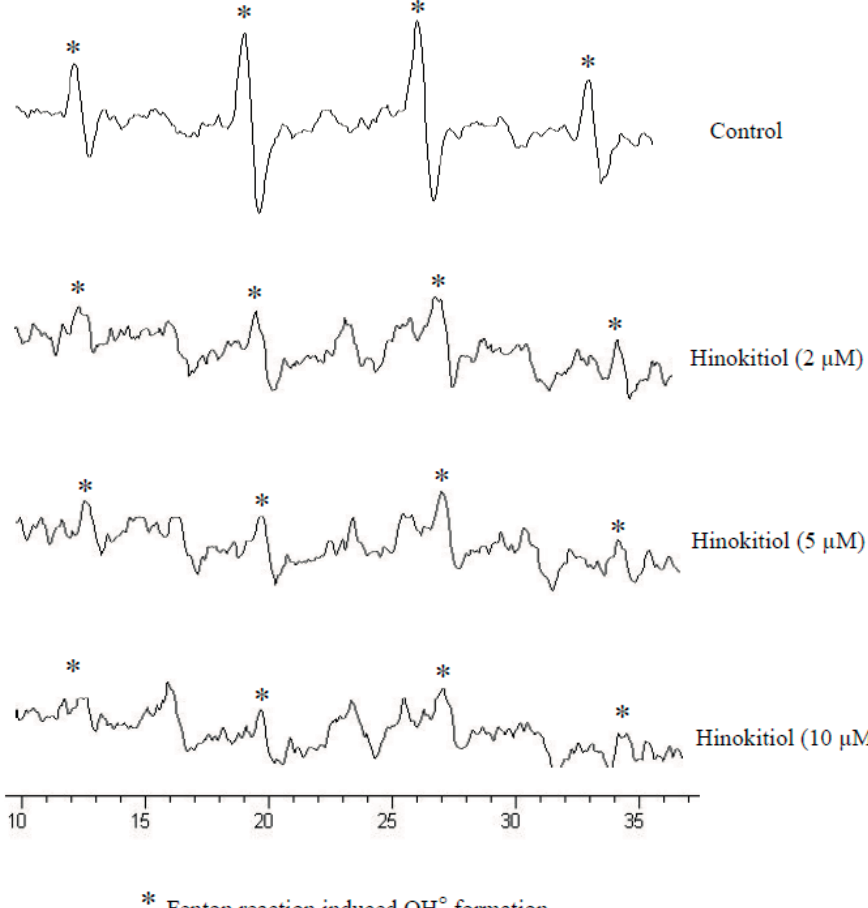
Figure 4. Effects of the extracts of hinokitiol on hydroxyl radical formation; ESR spectra shows the hinokitiol (2–10 µM) significantly inhibits Fenton reaction induced hydroxyl radical formation in a dose dependent manner. Data are presented as the mean ± S.E.M; * indicates Fenton reaction induced OH·